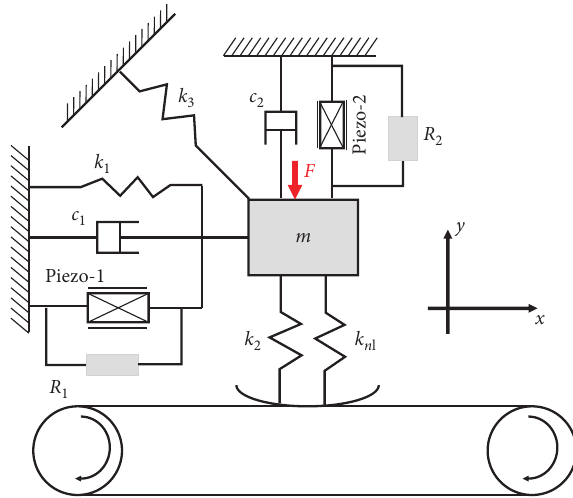
Figure 16: Two-degree-of-freedom friction system with piezoelectric